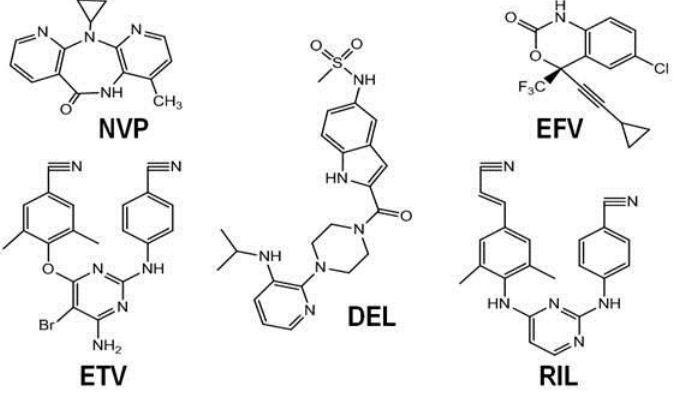
Figure 3. Chemical structures of USFDA-approved non-nucleoside RT inhibitors